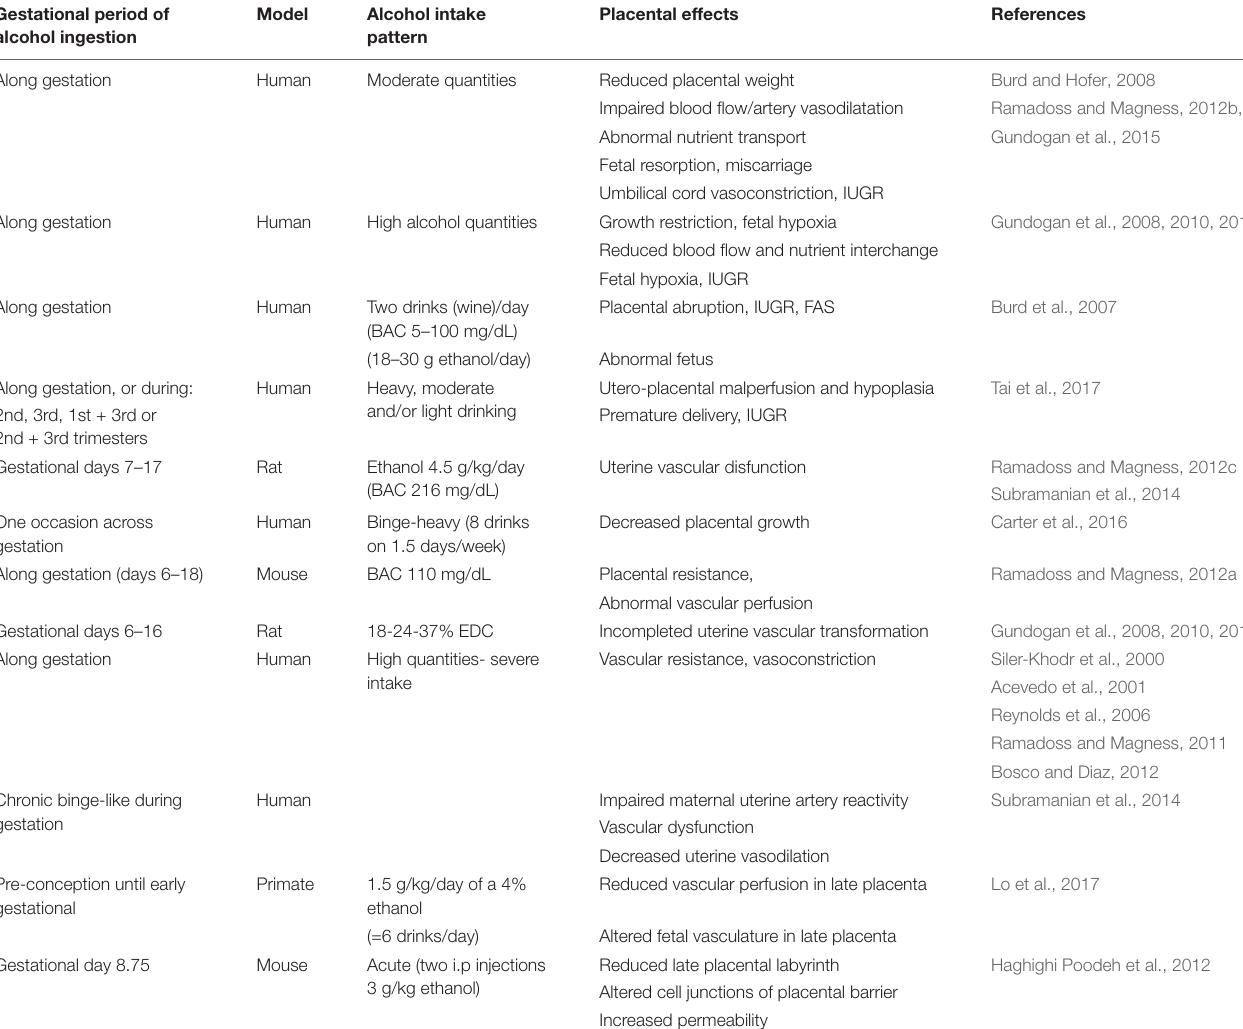
TABLE 1 | Summary of the main findings on the placental effects produced by gestational alcohol